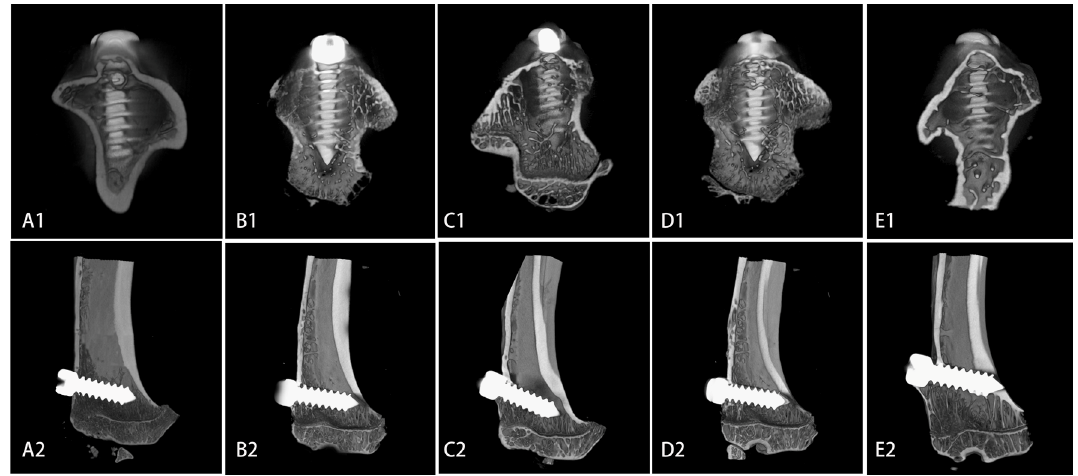
Figure 4. Micro-computed tomography (Micro-CT) images of the proximal tibia with implants in ( A ) Ti group; ( B ) brushite group; ( C ) 5% Sr group; ( D ) 10% Sr group; ( E ) 20% Sr group; 1 : vertical axis; 2 : long axis.